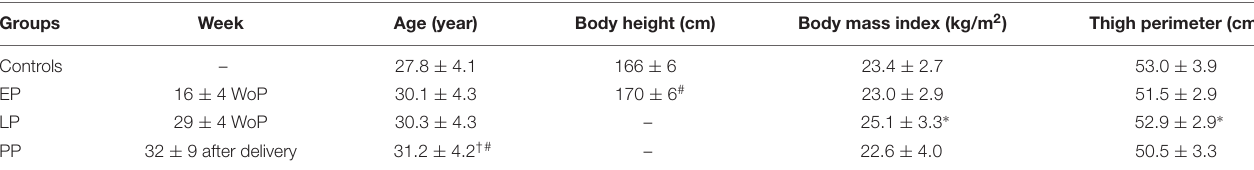
TABLE 1 | Anthropometric data for the non-pregnant controls and the pregnant women at the early (EP) and late (LP) stage of pregnancy as well as postpartum (PP) (means ± standard deviation).